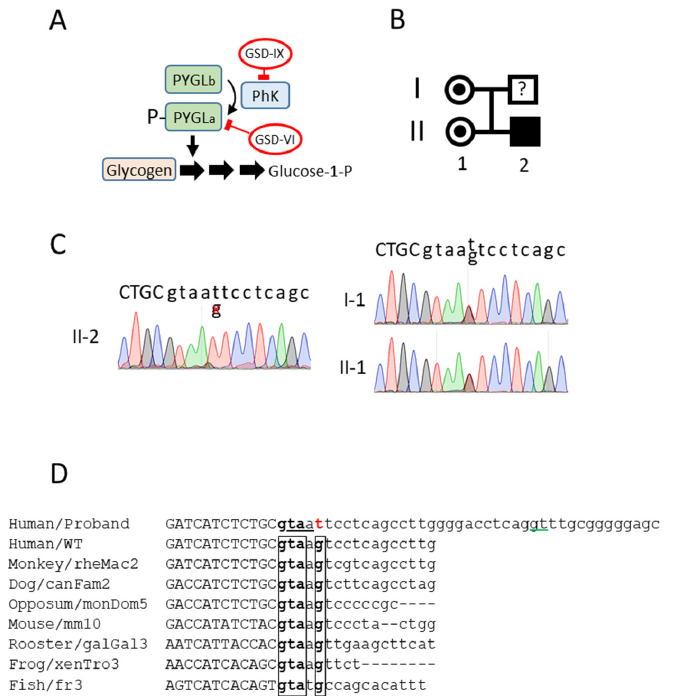
Figure 1. PHKA2 novel mutation. ( A ) The role of glycogen phosphorylase (PYGL) and phosphorylase kinase (PhK) in glycogen catabolism. ( B ) Family tree of the proband. ( C ) Sanger sequencing of genomic DNA from the proband, proband’s sister, and proband’s mother. The boundary between exon23/intron23 is depicted. The exon sequence is in capital letters. ( D ) Alignment of the PHKA2 exon23/intron23 junction of the novel variant with the human wild type and multiple animal